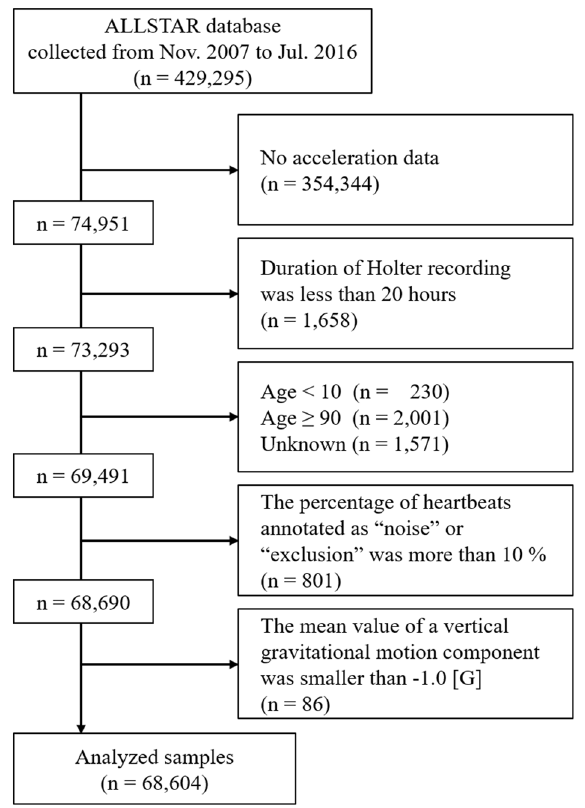
Figure 1. Flow chart of data availability.